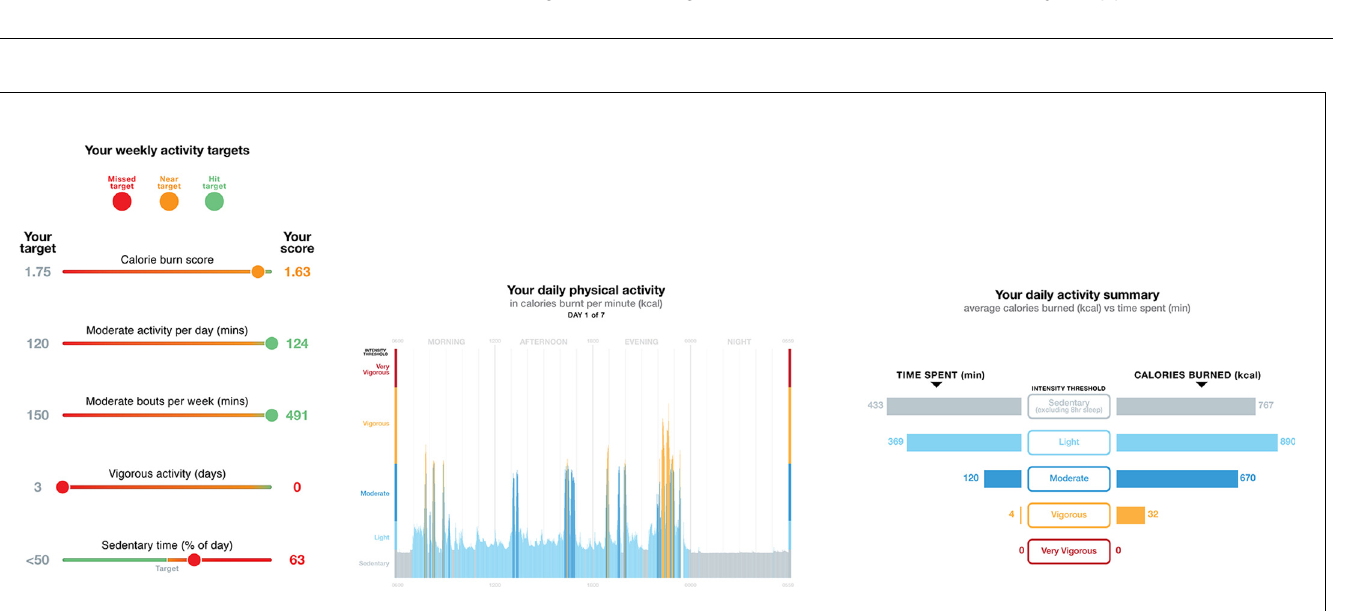
Western M J et al . BJGP Open 2019; DOI: